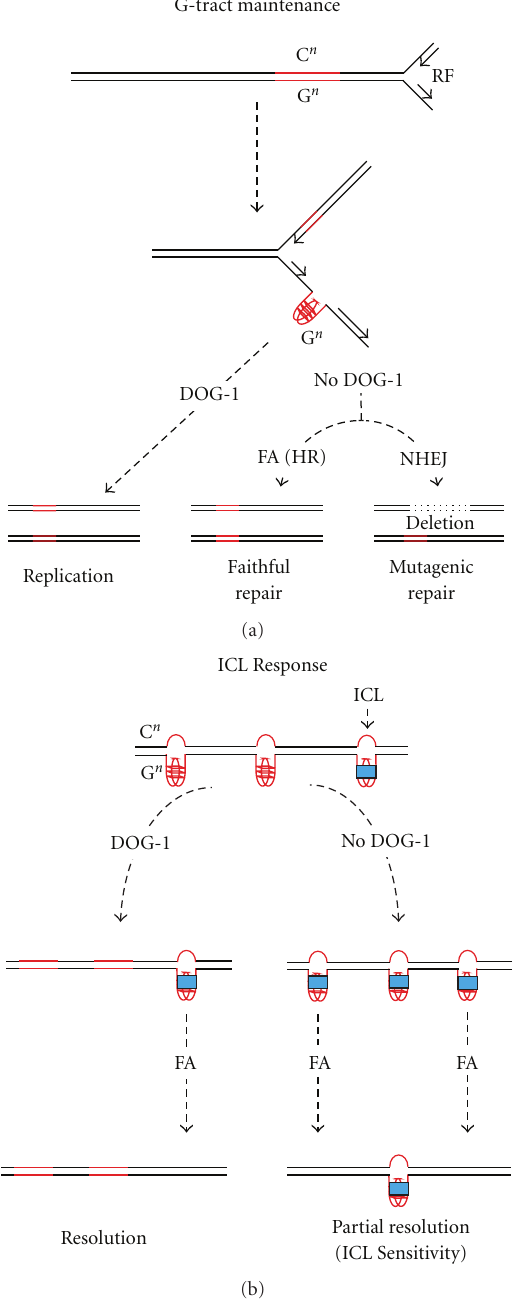
Figure 3: A model for DOG-1 function in genome stability and ICL response. The left panel illustrates DOG-1’s role in G-tract maintenance. G4 formation on the lagging strand is resolved by the helicase function of DOG-1 and replication proceeds e ffi ciently. In the absence of DOG-1 HR mediated by the FA pathway resolves a subset of stalled forks. Repair utilizing the mutagenic NHEJ repair mechanism results in deletions. The right panel describes a possible model for DOG-1 ICL sensitivity. In the presence of DOG-1, G4 structures may be resolved and not available as substrate for ICL stabilization. In the absence of DOG-1 G4 structures are available as substrate for ICL stabilization leading to an in increase in fork stalling, which is interpreted as an ICL sensitivity